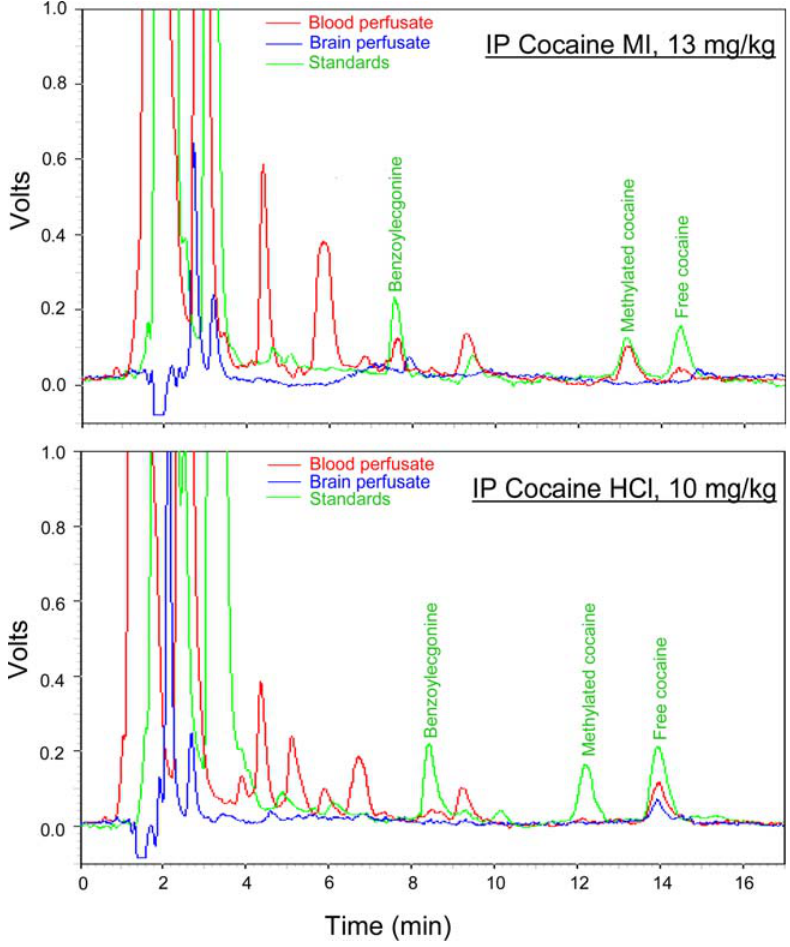
Figure 4. Illustrative chromatograms from blood (red line) and brain (blue line) dialysates taken from an animal given IP cocaine MI (13 mg/kg) (top panel) and an animal given IP cocaine HCl (10 mg/kg) (bottom panel). The green line shows a chromatogram from a standard solution containing free cocaine, methylated cocaine, and the primary cocaine metabolite bonzoylecgonine.